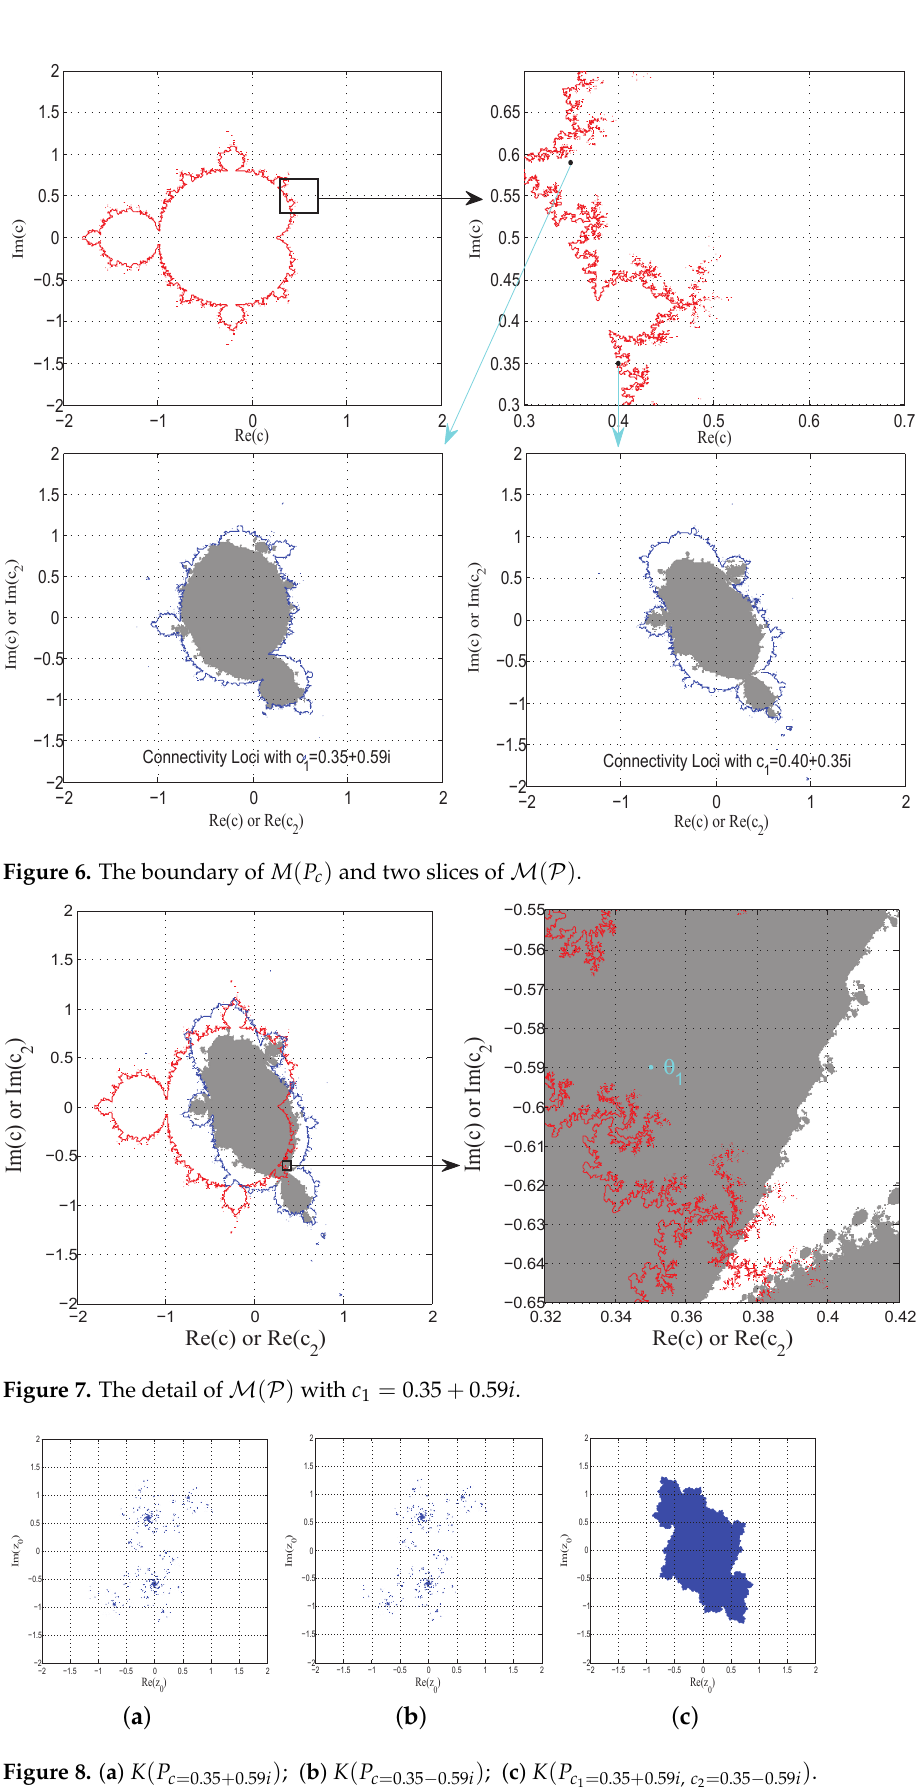
Figure 8. ( a ) K ( P c = 0.35 + 0.59 i ) ; ( b ) K ( P c = 0.35 − 0.59 i ) ; ( c ) K ( P c